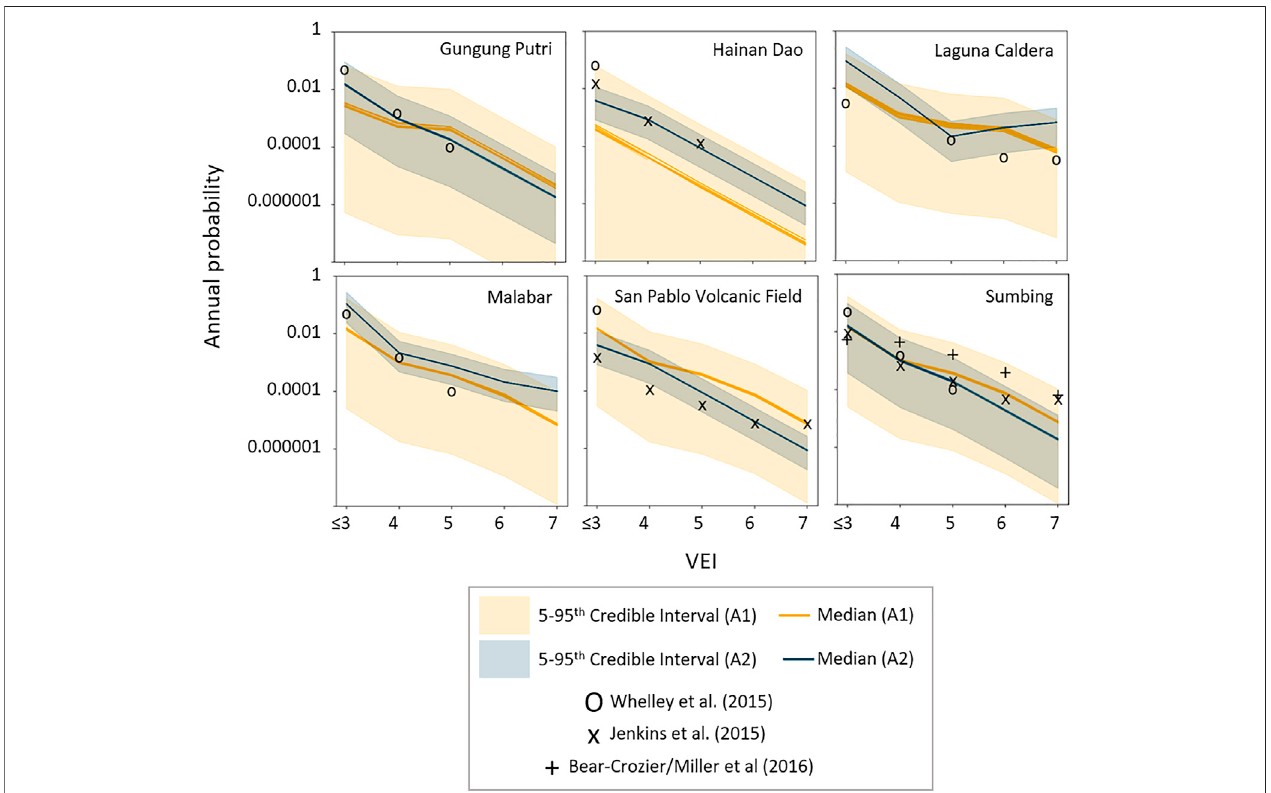
FIGURE 11 | Analogue frequency-magnitude distributions compared to published point estimates from the literature for volcanoes that could not undergo Bayesianupdatingduetolittle/noeruptionrecord.Note:VEIisdiscretedatathatarepresentedascontinuousdatatoemphasizetherelationshipbetweenVEIandannual probability.